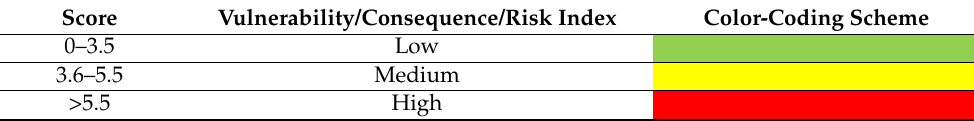
Table 2. Risk classification and color-coding